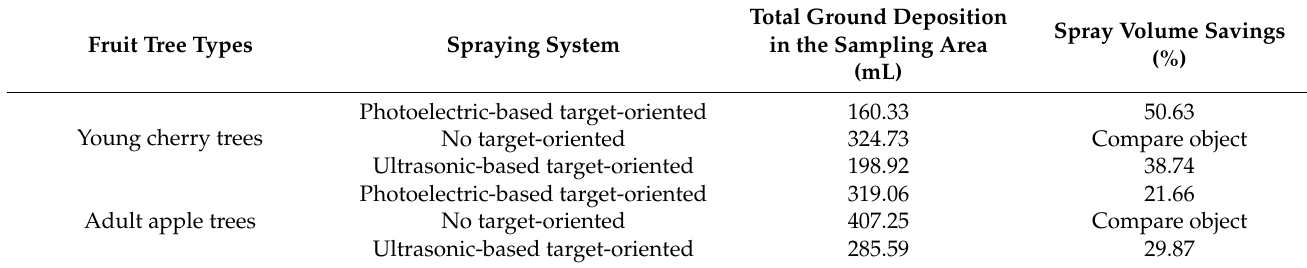
Table 3. Spray volume savings under different spraying systems.